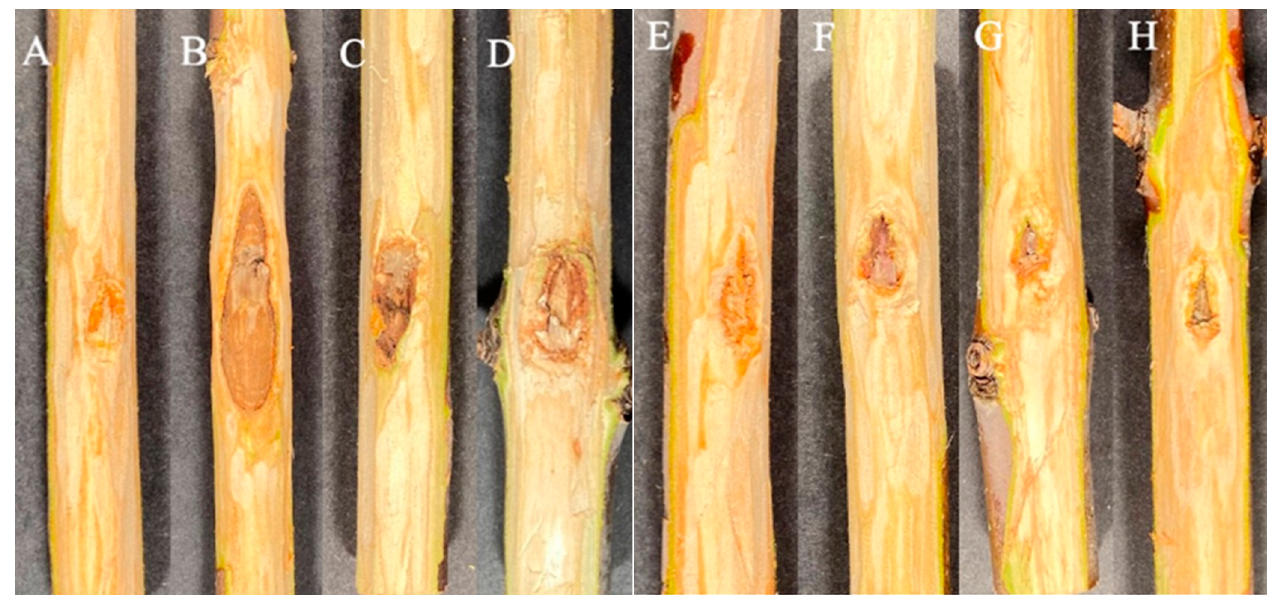
Figure 2. White ash stems from Experiment 2 to demonstrate the lesion size that is representative of the fungus and treatment. From left to right: ( A ) Control, ( B ) Diplodia mutila (EAB 42-6), ( C ) Diplodia seriata (EAB 64-12), ( D ) Cytospora pruinosa (EAB 67-4), ( E ) Thyronectria aurigera (EAB 45-20), ( F ) Phaeoacremonium scolyti (EAB 64-22), ( G ) Phaeoacremonium minimum (EAB 66-10), and ( H ) Paraconiothyrium brasiliense (EAB 58-13).